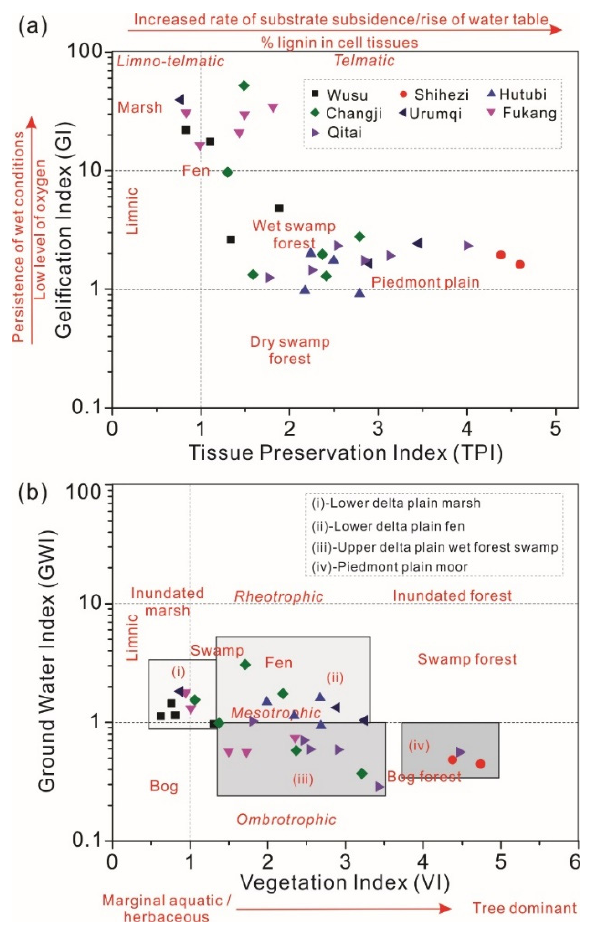
Figure 6. Coal facies indices considering the pseudovitrinite for the selected samples from the southern Junggar coalfield. ( a ) A gelification index (GI) vs. tissue preservation index (TPI) plot (base map modified from [20]); ( b ) a ground water index (GWI) vs. vegetation index (VI) plot (base map modified from [52]).